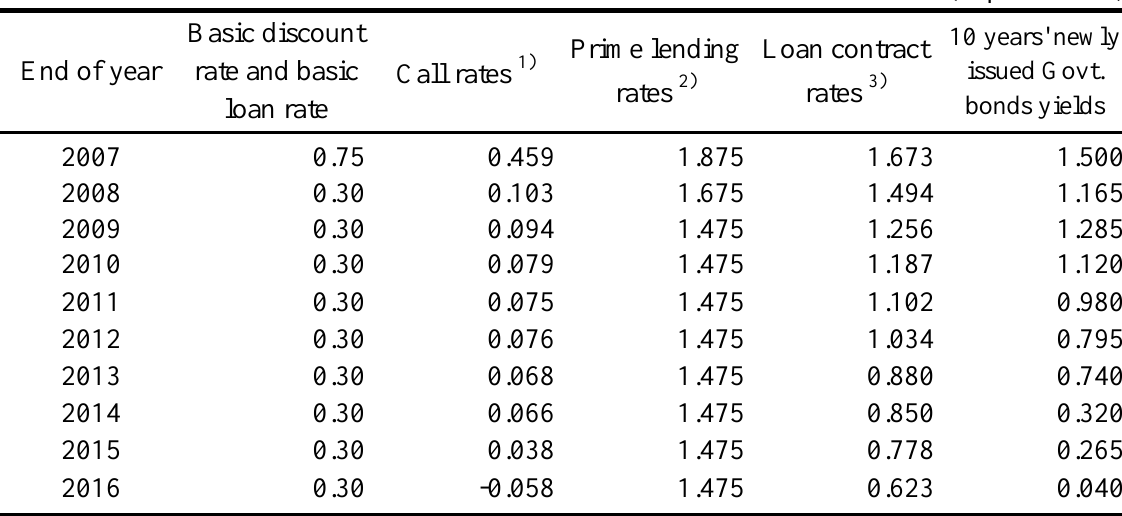
Financial Markets (Interest rates,